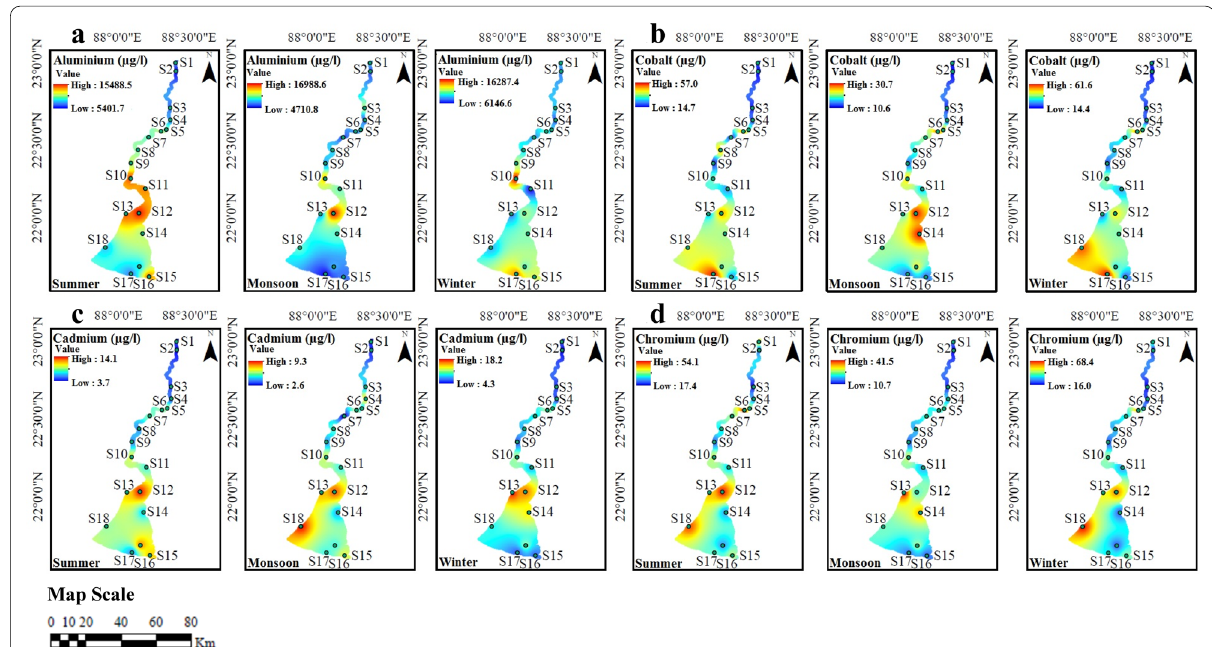
Fig. 2 Geospatial distribution of dissolved Aluminium (Al), Cadmium (Cd), Cobalt (Co), and Chromium (Cr) in river Hooghly. a Al, b Cd, c Co, and d Cr